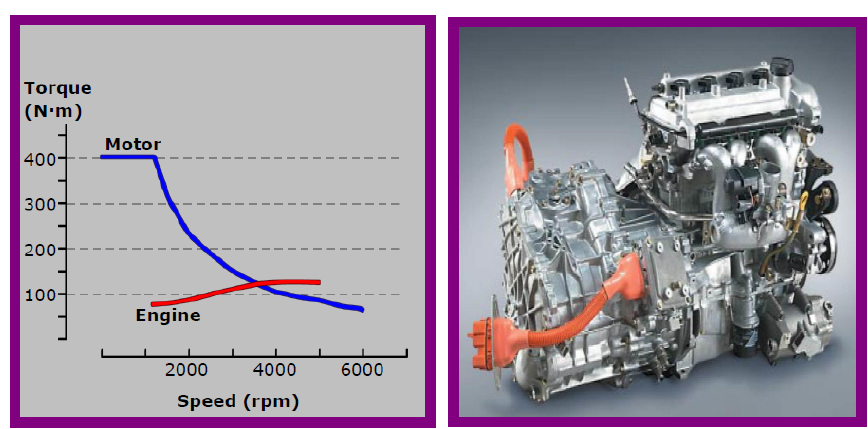
Figure 11. The relations between torque and speed for the hybrid system. Source [35].